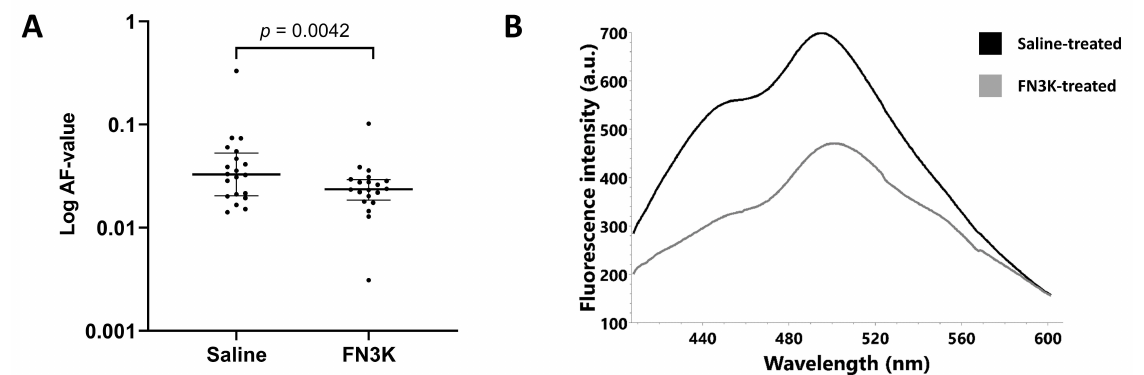
Figure 5. ( A ) Autofluorescence (AF) values of the enucleated lenses of ob/ob ( n = 20) mice after in vivo intravitreal injection with saline (left eye) or FN3K (right eye). Data are displayed as the median and interquartile range (log scale). ( B ) Median fluorescence emission spectra (400–620 nm range) of the murine lenses after in vivo saline (black line) or FN3K (grey line) treatment. A.u., arbitrary units; nm, nanometer.